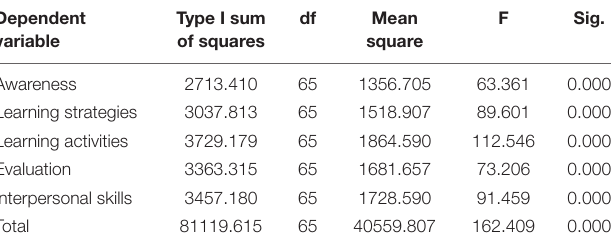
TABLE 1 | ANOVA of self-directed learning skills.